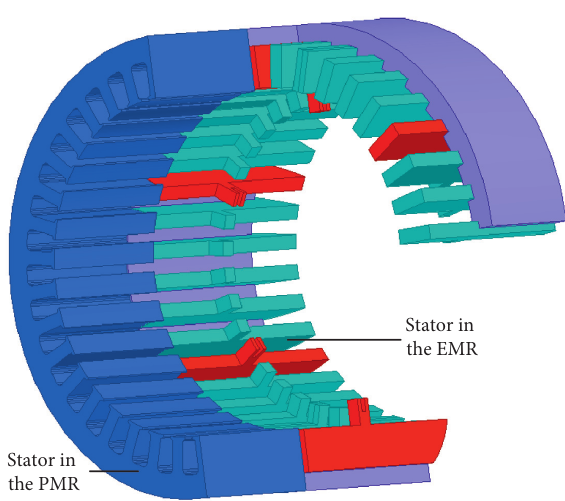
Figure 7: The structure of the stator of the